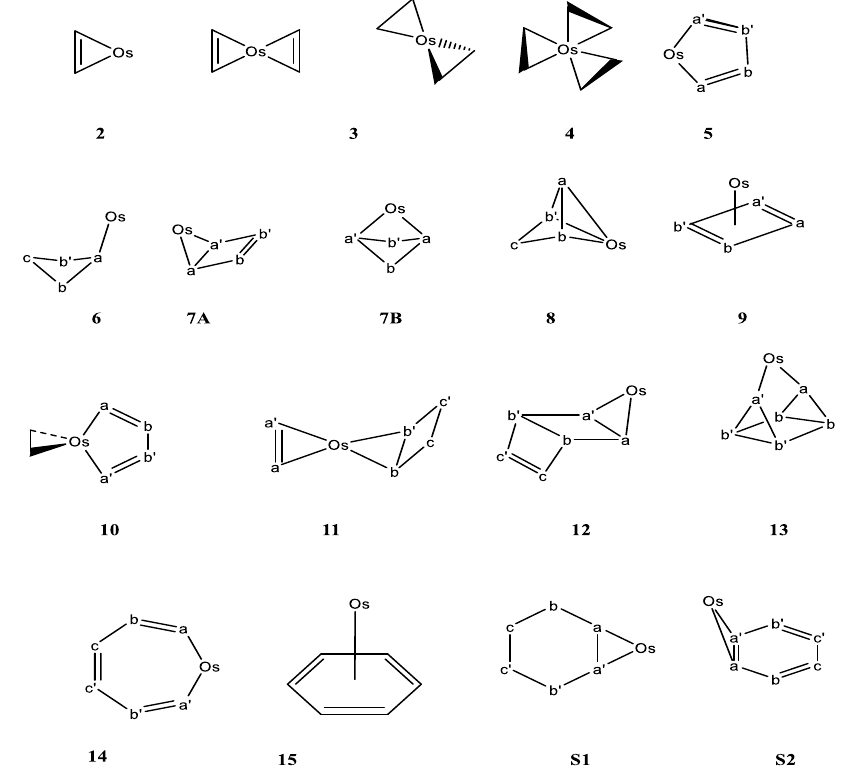
Figure 1. Some of the structures described in this